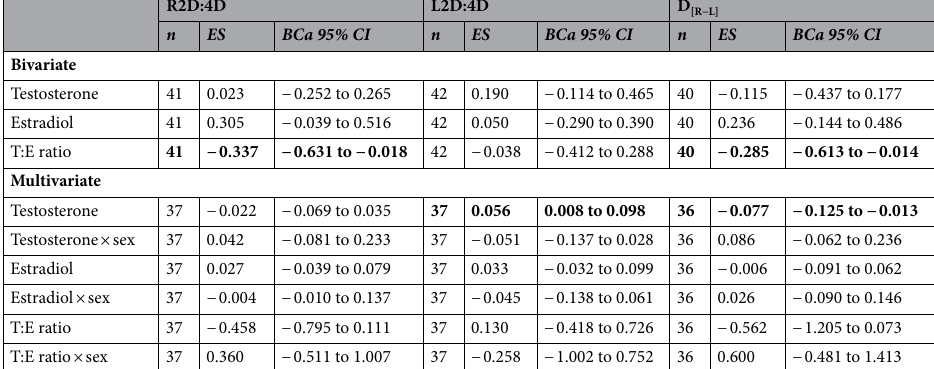
Table 2. Associations between maternal hormone concentrations and offspring digit ratios. BCa 95% CI = bias corrected and accelerated 95% confidence intervals. Bivariate analyses are boostrapped (10,000 resamples) Pearson’s correlations; multivariate analyses are bootstrapped (10,000 resamples) multiple linear regression. ES = effect size (Pearson’s r for bivariate analyses; β for multivariate analyses). The following variables were included as covariates in the multivariate analyses: child’s sex (0 = female, 1 = male), maternal polycystic ovary syndrome (PCOS) status (1 = absent, 2 = present), maternal hirsutism score (1 = no areas affected, 2 = one area affected, 3 = more than one area affected), child’s birth weight (grams), child’s age at follow-up corrected for gestational age (days). Statistically significant effects (i.e., those for which the BCa 95% CIs do not include 0) are presented in